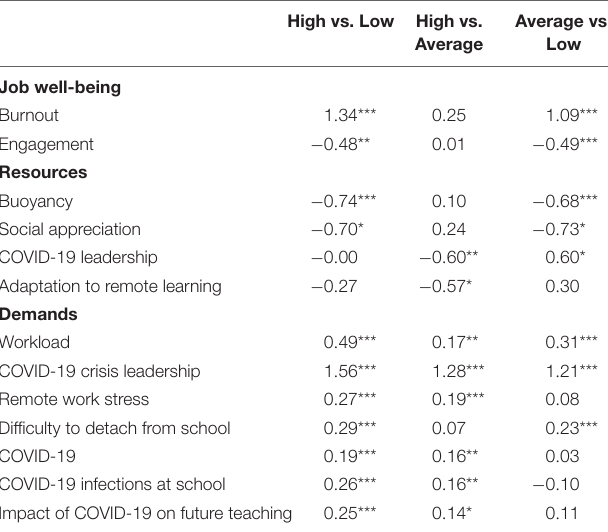
TABLE 3 | Antecedents of school principals stress source profiles (logistic regression coefficients).